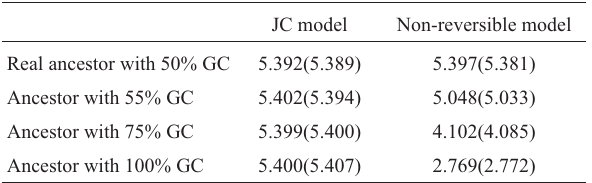
Table 3 - Mean and variance (in parenthesis) of the branch lengths distribution of the generation 840 for the JC model and the non-reversible model, for the four types of ancestors of the computer simulation of neutral